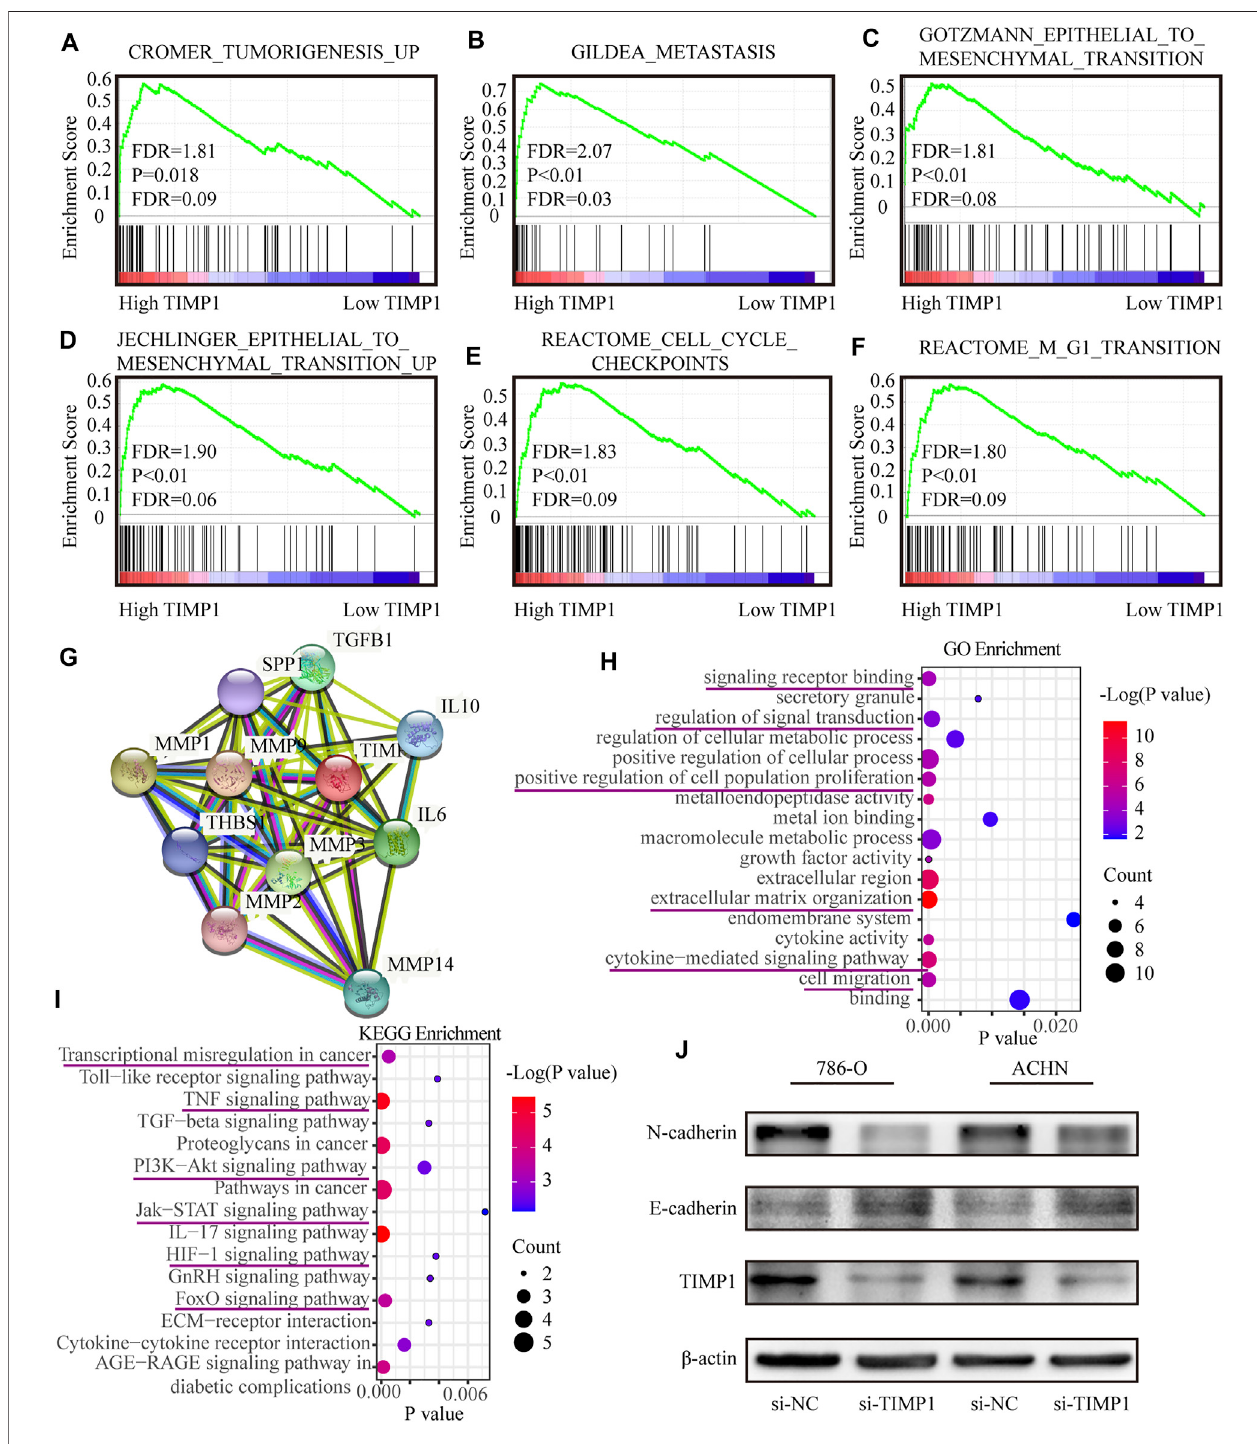
FIGURE 9 | TIMP1 was involved in multiple biological processes and promoted RCC via EMT pathway. (A – F) GSEA analysis for the correlations between the biological pathways with the levels of the TIMP1 mRNA based on TCGA database. FDR < 25% and p < 0.05 were considered statistically signi fi cant. (G) The protein- protein interaction network of TIMP1. (H,I) Biological processes and KEGG pathways in STRING. (J) Veri fi cation of N-cadherin and E-cadherin protein changes after silencing TIMP1 in 786-O and ACHN. TIMP1, Tissue inhibitor matrix metalloproteinase 1, KEGG (Kyoto Encyclopedia of Genes and Genomes).